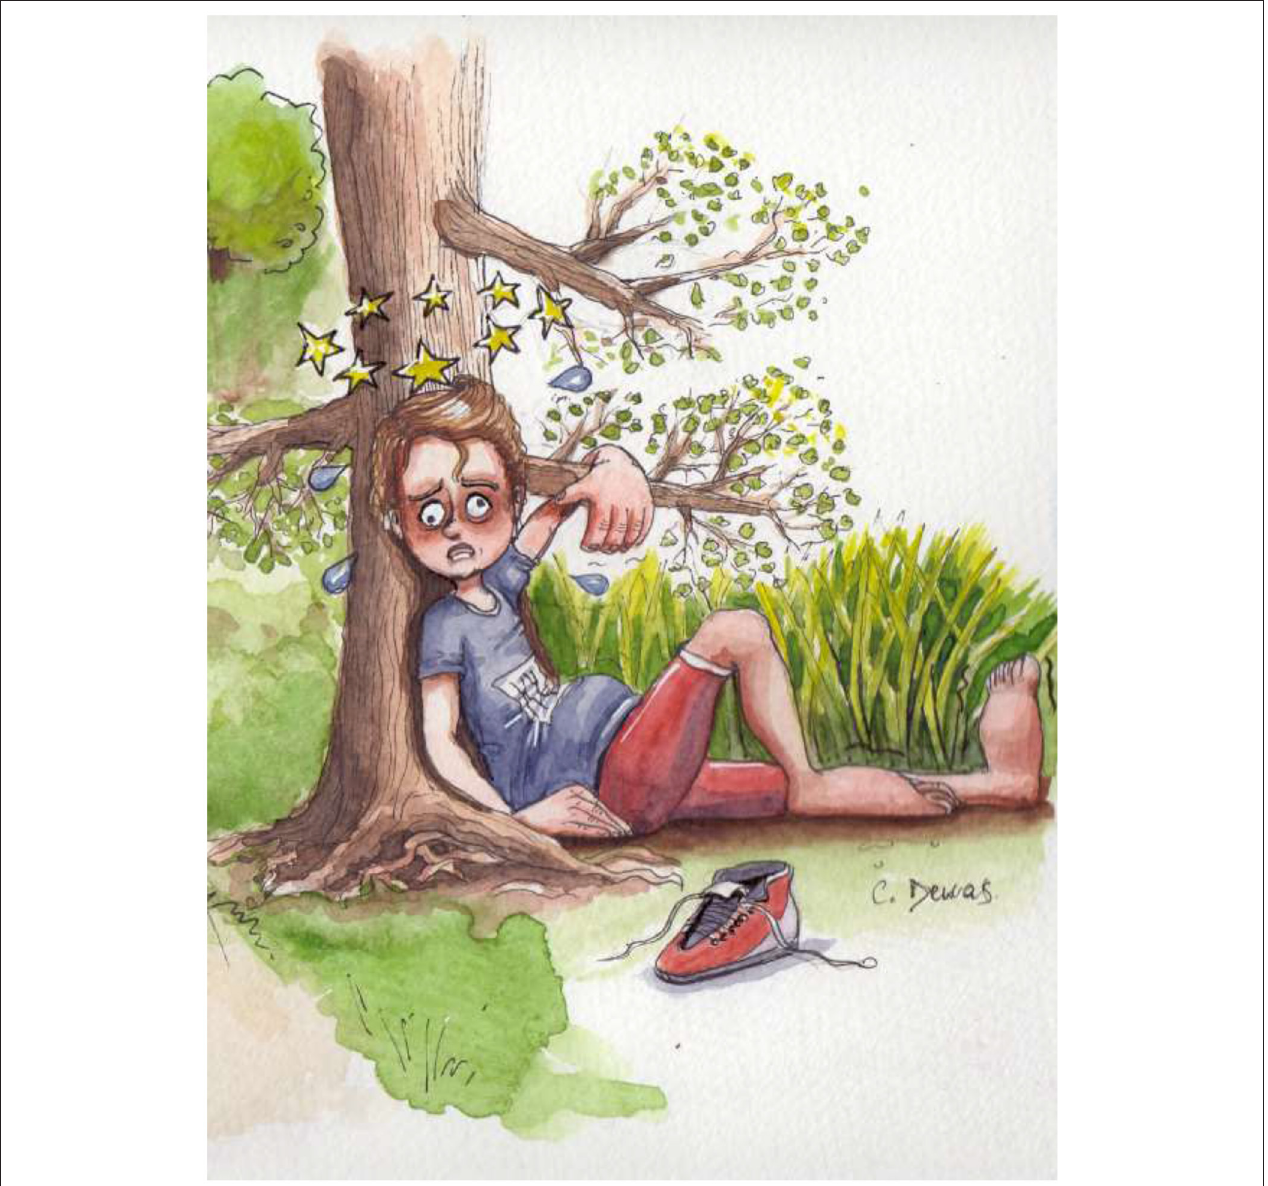
FIGURE 3 | Fluid overload can result in exercise-associated hyponatremia, limb swelling and exercise-associated hyponatremic encephalopathy. Figure by Céline